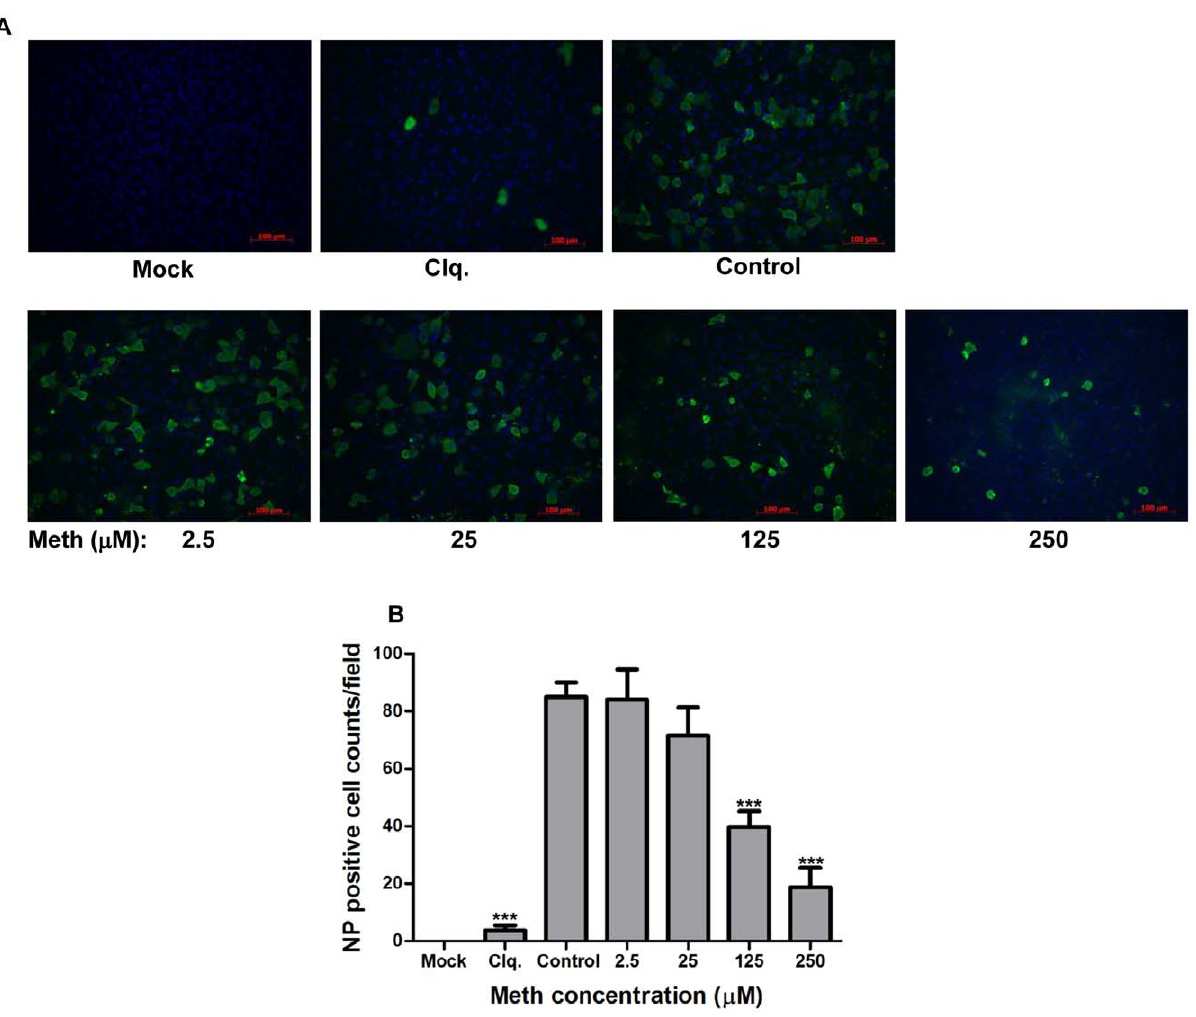
Figure 6. Meth reduces susceptibility to influenza A virus infections in human lung epithelial A549 cells. (A) A549 cells grown on glass coverslips were left un-treated, or treated with chloroquine (Clq.; 10 m M; as positive control) or meth at indicated concentrations, followed by the infection with influenza A/WSN/33 (H1N1) virus at an MOI of 1 PFU/cell in the absence of trypsin (single-cycle growth) and presence of the corresponding drugs at indicated concentrations. At 24 h post-infection, cells were fixed with formaldehyde and subjected to immunofluorenscence staining for detecting the infected cells by using an antibody against viral nucleoprotein (NP; green); cellular nuclei were located by DAPI staining (blue). A representative result from three independent experiments is shown. Mock: cells were neither exposed to the drugs nor infected with the virus. Scale bar: 100 m m. (B) NP-positive cells were counted from ten microscopic fields with . 90% cell confluence. Data are expressed as mean values 6 SD from a representative result of three independent experiments. Significant differences from the drug-untreated infected group (control) were indicated (***: p , 0.0001).